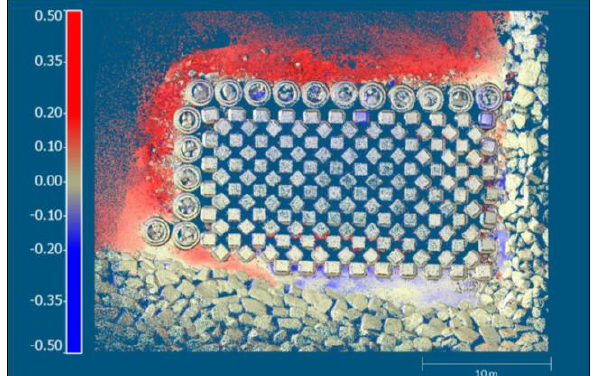
Figure 11. June / November differences [m]